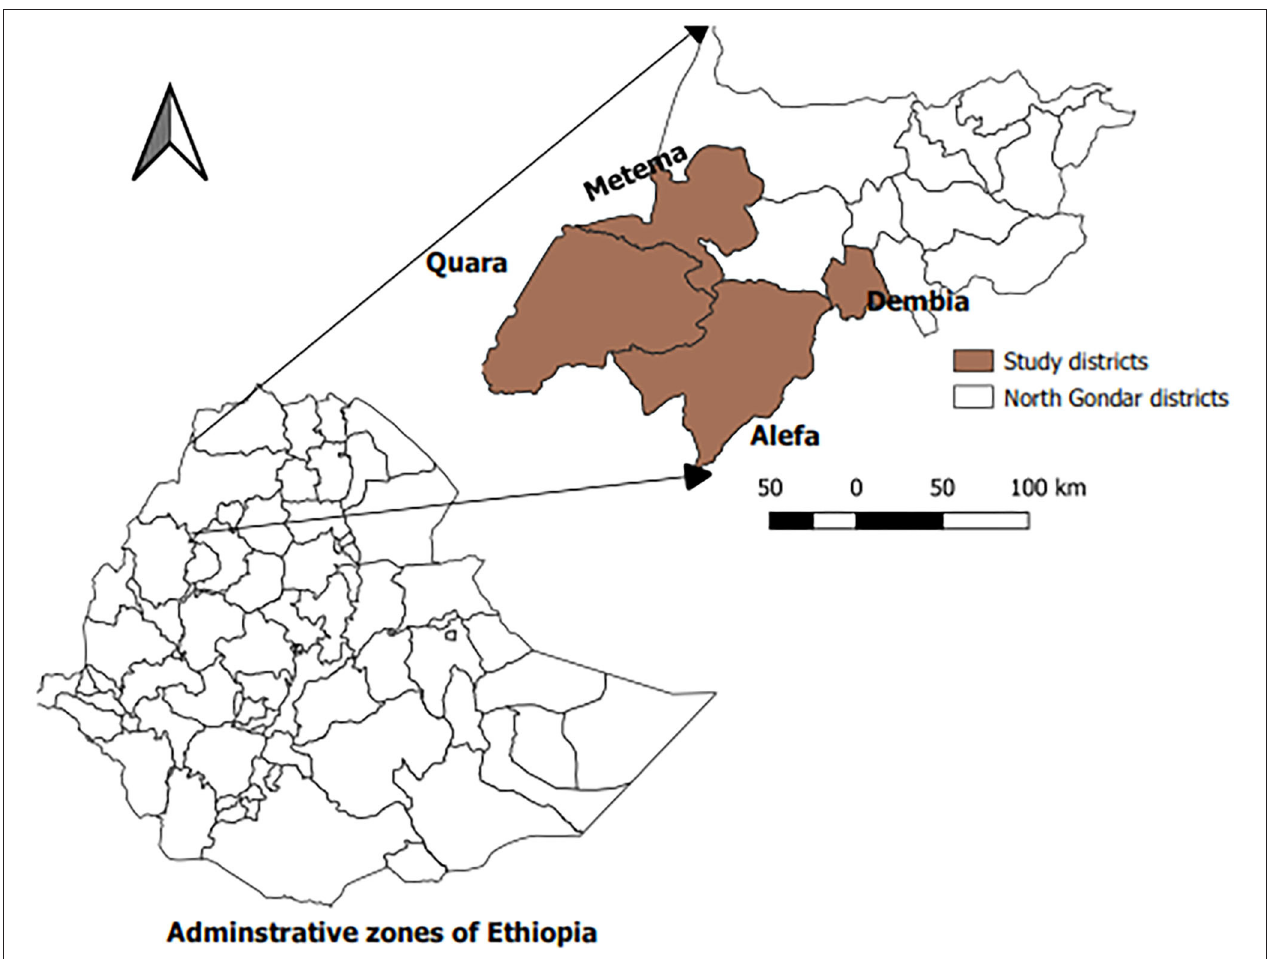
FIGURE 1 | Map of Ethiopia showing the study districts in North Gondar